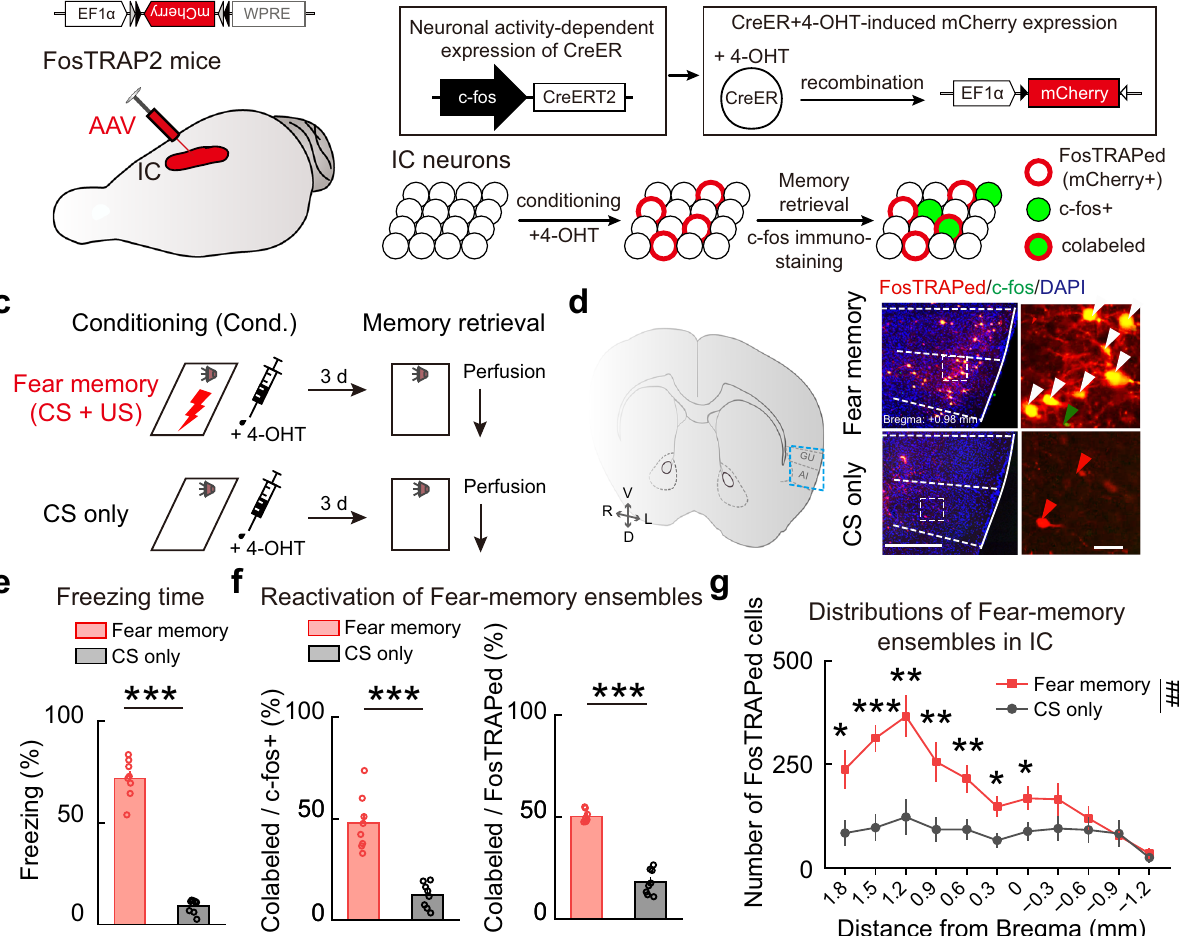
learningandmemoryretrieval.Left:thepercentageofcolabeledneuronsversusall c-fos+ neurons. t (14) =6.676, *** P =1.0502E − 05, two-tailedunpaired Student ’ s t test. Right: the percentage of colabeled neurons versus all FosTRAPed neurons. t (14) =13.44,*** P =2.1653E − 09,two-tailedunpairedStudent ’ s t test. g Distributionof FosTRAPed neurons along the anterior-posterior axis of IC. Bregma+1.80: t (14) =2.836, * P =0.0132; +1.50: t (14) =5.000, *** P =1.9452E − 04; +1.20: t (14) =3.770, ** P =0.0021; +0.90: t (14) =3.005, ** P =0.0095; +0.60: t (14) =3.073, ** P =0.0083; +0.30: t (14) =2.931, * P =0.011; +0.00: t (14) =2.347, * P =0.0342; − 0.30: t (14) =1.532, P =0.1478; − 0.60: t (14) =0.7051, P =0.4923; − 0.90: t (14) =0.1590, P =0.8759; − 1.20: t (14) =0.7288, P =0.4781; two-tailed unpaired Student ’ s t test. All: F (1, 14) =9.718; ** P =0.0076, two-way repeated measures ANOVA. Data are presented as mean values±SEM and the error bar represents SEM. Source data are provided as a Source Data fi